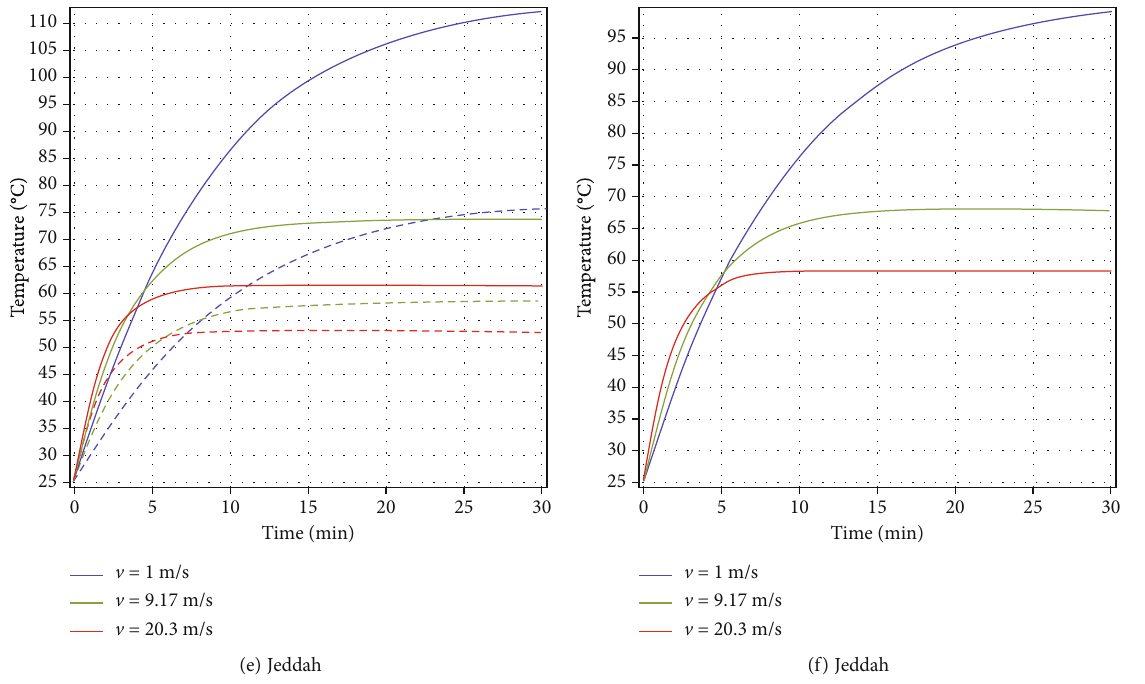
Figure 4: Average temperature of a PV panel at noon for di ff erent wind velocities; without mirrors (dashed) and with mirror (solid) for (a – e) double coverage case and (f) partial coverage